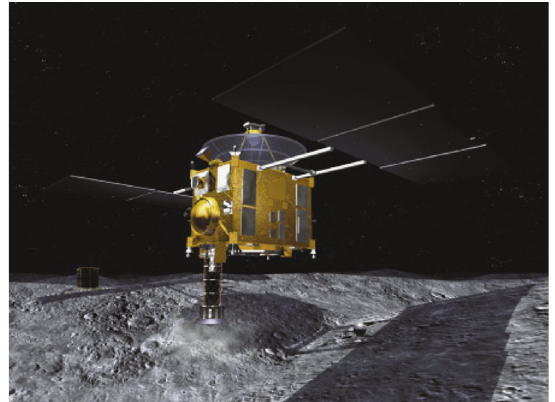
Figure 1: Japanese Hayabusa explorer.